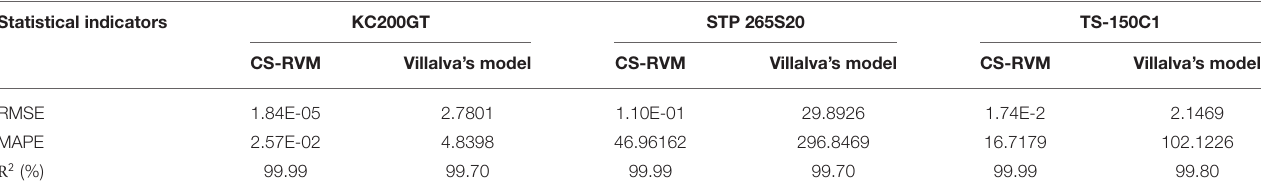
TABLE 2 | RMSE, MAPE, and R 2 values of prediction of current by the CS-RVM and Villalva’s model. Statistical